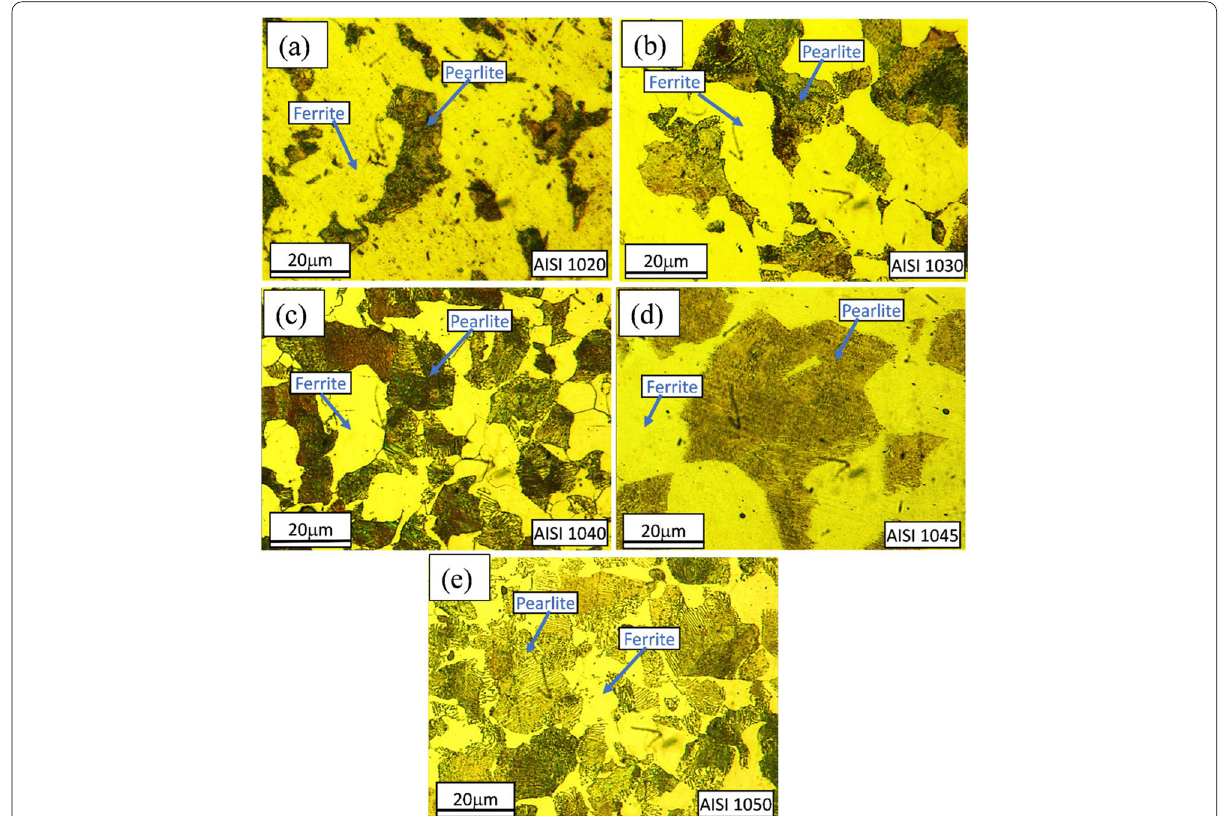
Fig. 2 Light optical micrographs of AISI a 1020, b 1030, c 1040, d 1045, and e 1050 plain carbon steels obtained after annealing showing coarse ferritic-pearlitic